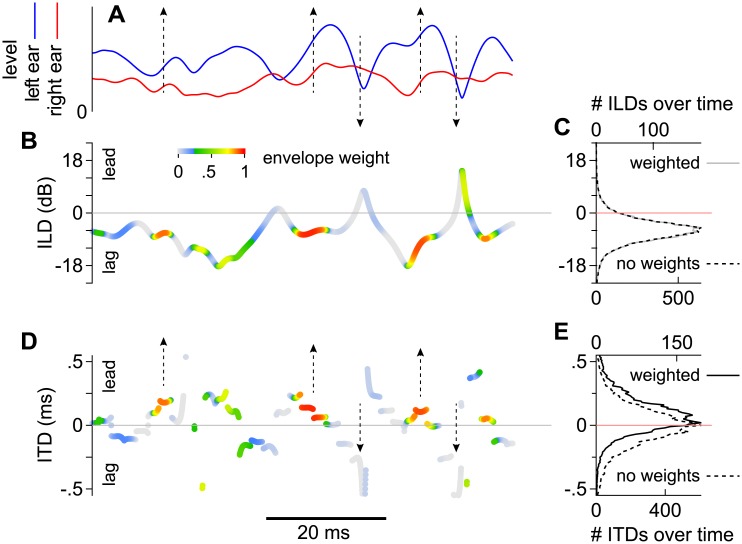
Demonstration of how ITD may be shifted toward the leading source (positively).
(A) Amplitude envelopes of identical, 500 Hz, signals in the left and right ears when the lead-lag delay was 2.5 ms. (B) Measurements of ILD at the times when the signals were sampled, colored according to weights that were attributed to them by the envelopes of the left and right signals. (C) Distributions of weighted (solid line) and non-weighted (dashed line) ILDs measured when the leading and lagging noises pairs were superposed for 500 ms. (D) Measurements of ITD at the times when the signals were sampled, colored as in (B). (E) Distributions of weighted (solid line) and non-weighted (dashed line) ITDs measured when the leading and lagging noises pairs were superposed for 500 ms.